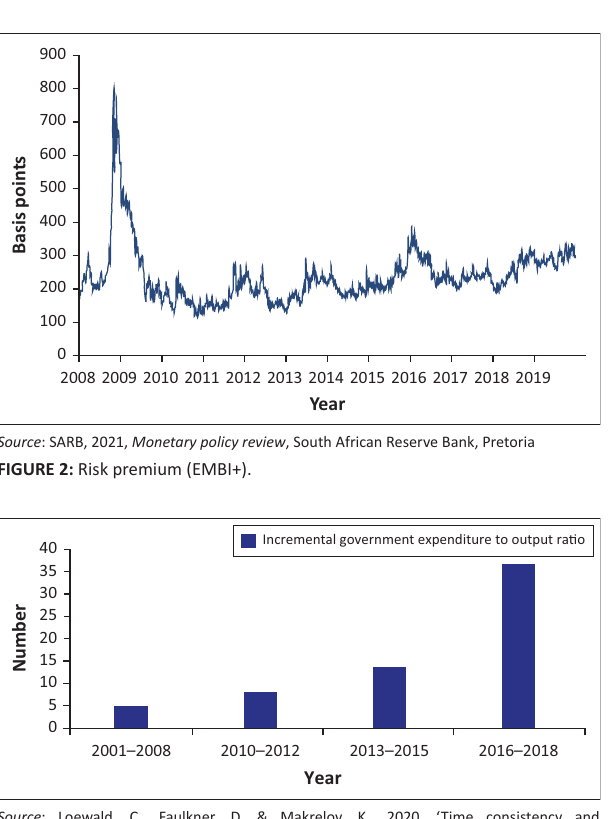
FIGURE 3: Government spending to growth.